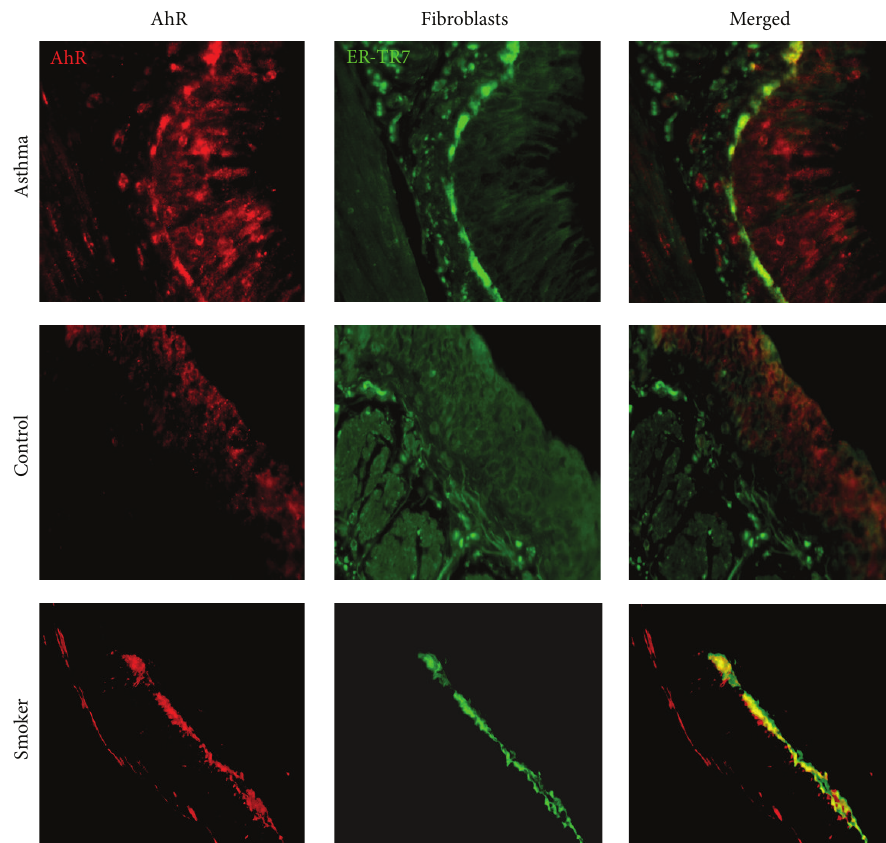
Figure 1: AhR expression in human airway. Immunofluorescence analysis of AhR expression in the airway, particularly fibroblasts from asthmatics (top), healthy individuals (middle), and heavy smokers (bottom), for antibodies against AhR (red) and fibroblasts marker (ER- TR-7, green). Figure 1 represents 4 individuals from each